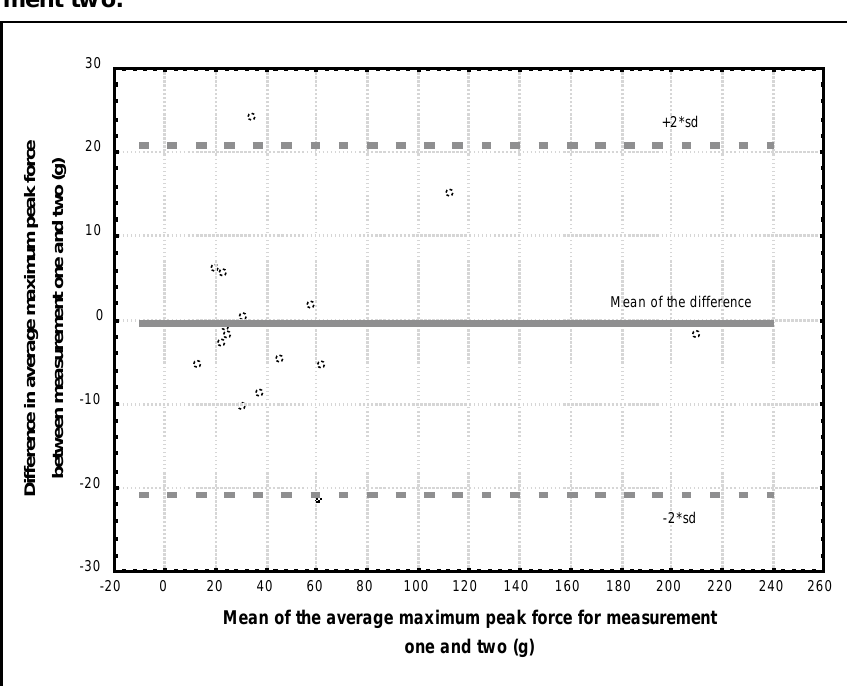
Figure 2: Bland Altman Scatterplot showing the repeatability of the average maximum peak force during a grade I p-a passive mobilization technique on C6, when measurement one is being compared to measure- ment